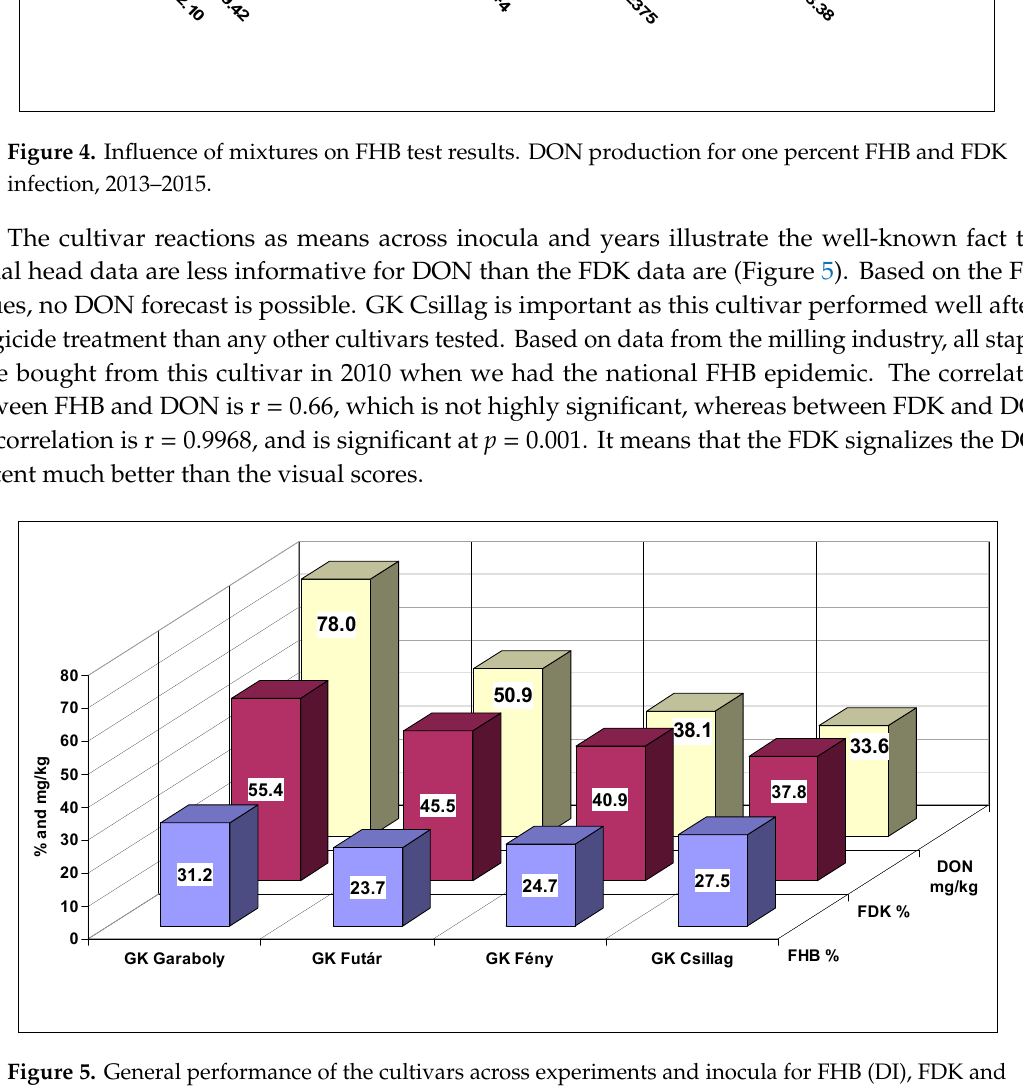
Figure 4. Influence of mixtures on FHB test results. DON production for one percent FHB and FDK infection, 2013–2015.